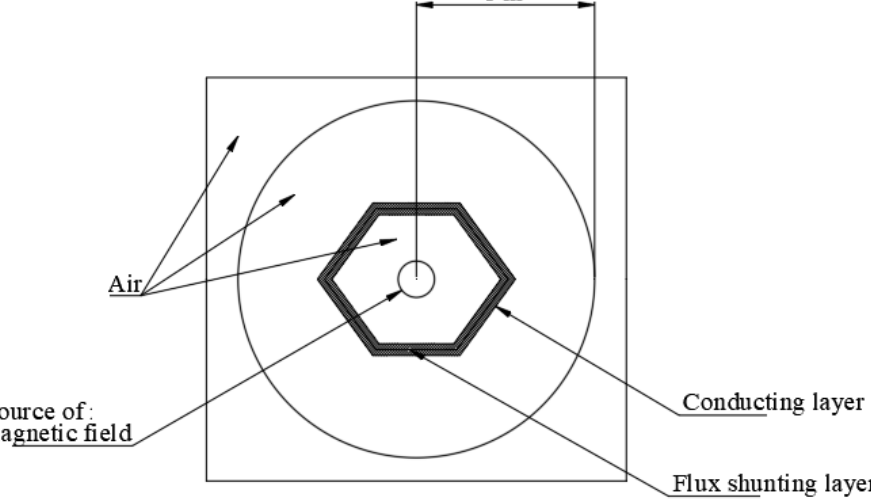
Figure 14. Arrangement of high frequency magnetic field shielding.